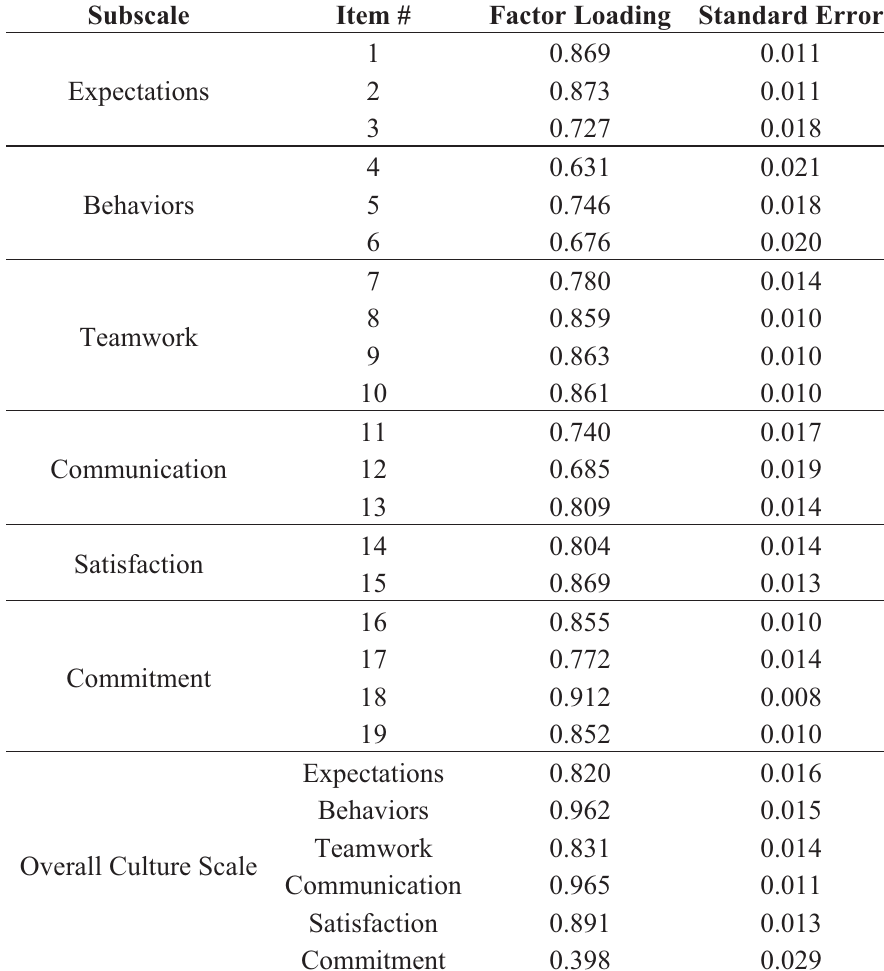
Table 2. Standardized Factor Loadings and Standard Error ( n =